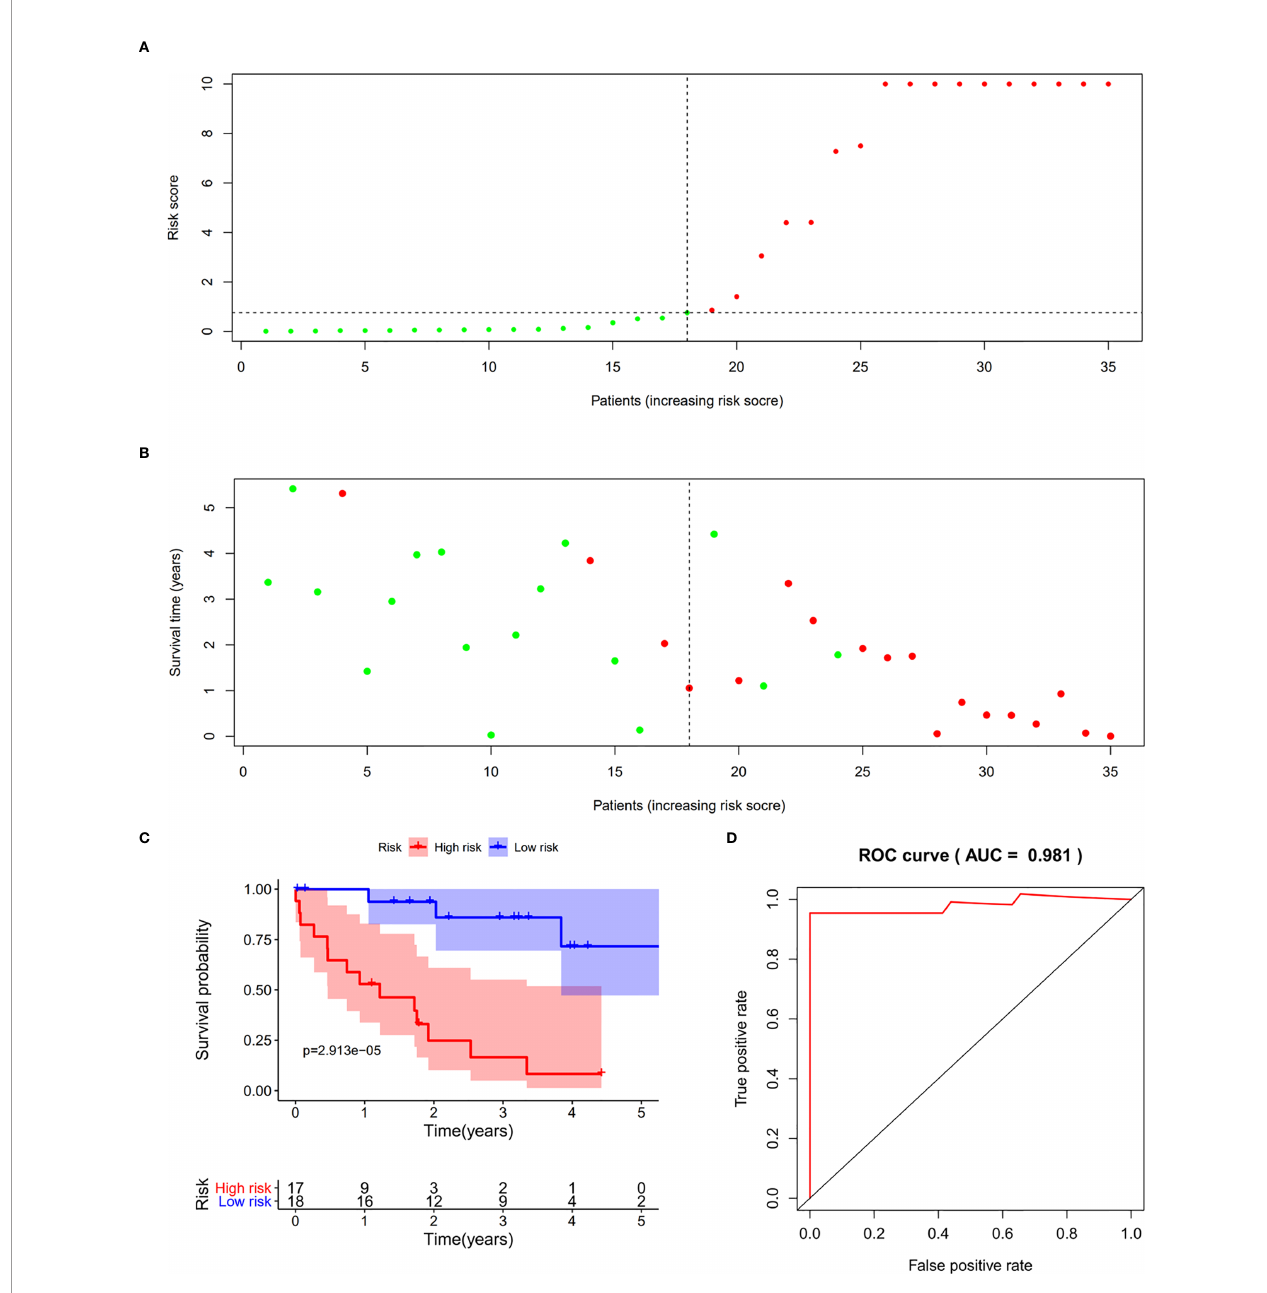
FIGURE 4 | Prognostic model validation. (A, B) Survival time and survival status of patients with different risk scores. (C) Survival curve of patients with high and low risk scores. (D) Receiver operating characteristic curve of the prognostic